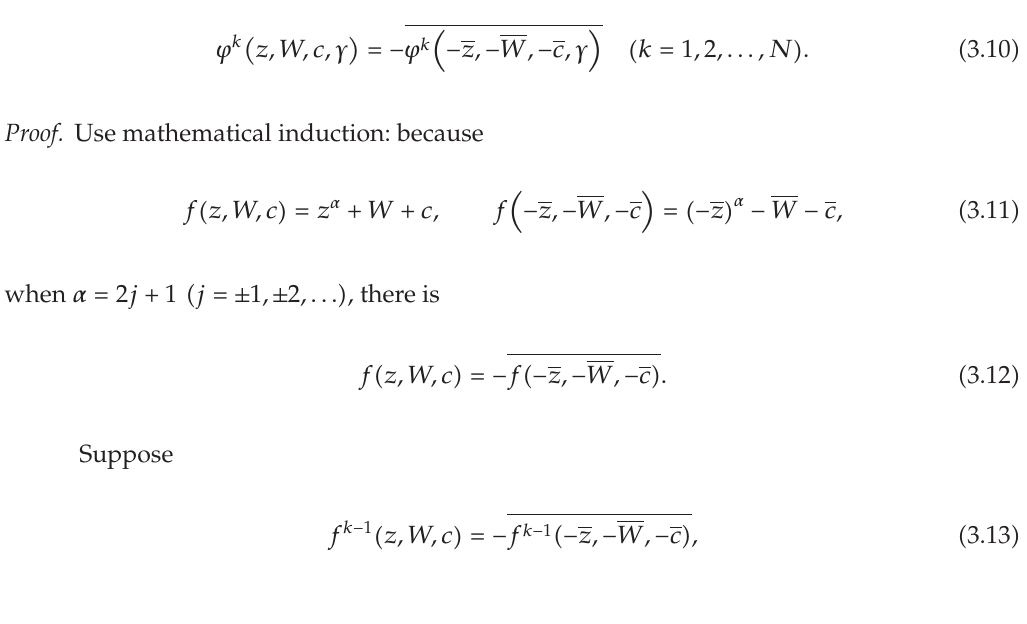
(cid:3) 3 (cid:4) rotating the graph with c (cid:6) a (cid:5) bi and the composing noise